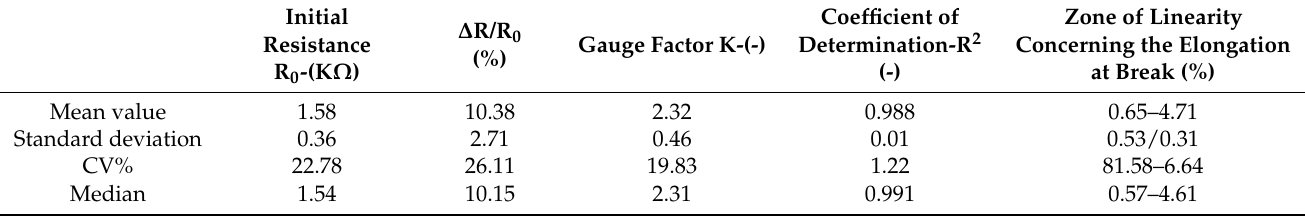
Table 2. Statistical results of the electromechanical behaviour of sensor yarns with 3 layers of piezoresistive coating.